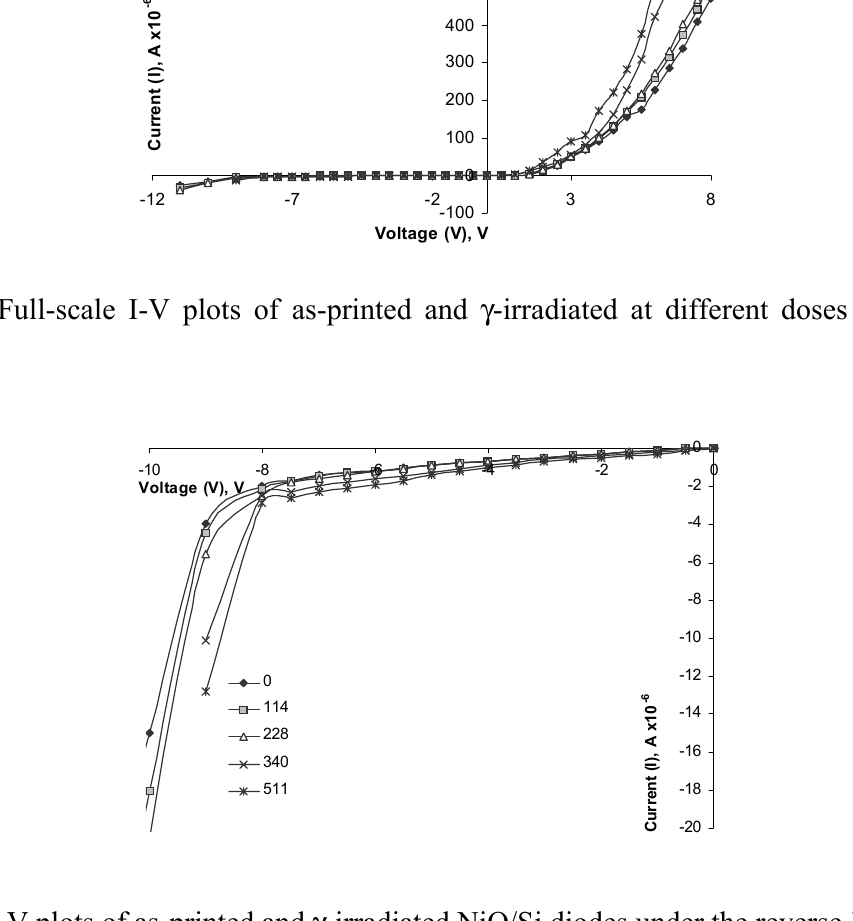
Figure 4. I-V plots of as-printed and γ -irradiated NiO/Si diodes under the